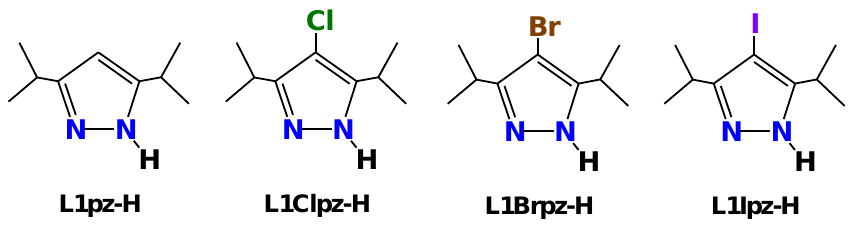
Figure 2. Pyrazoles used in this research.